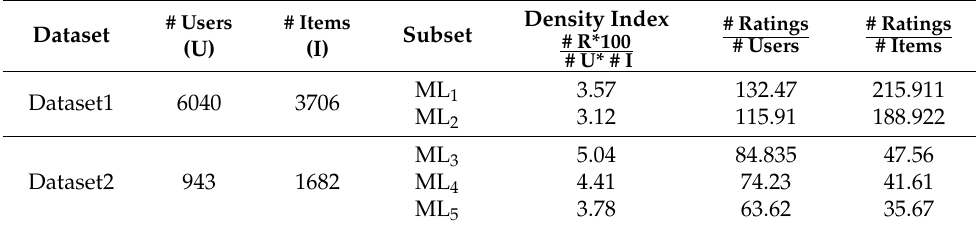
Table 14. Details of the subsets used in the experiments.